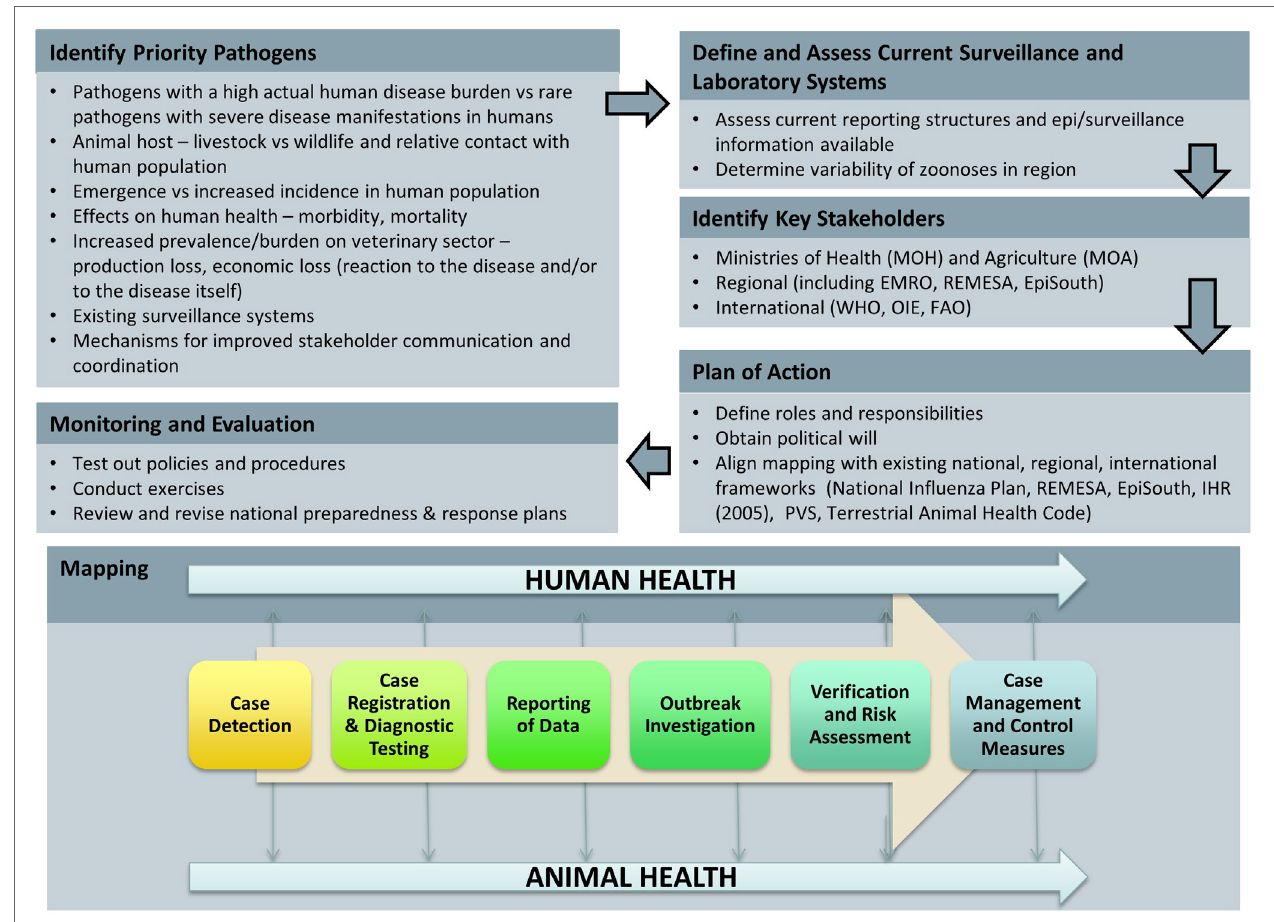
FigUre 2 | identifying priority zoonoses and identification and networks for case management . In order to select three priority zoonotic diseases for analysis, we considered MOH and MOA notifiable disease lists as well as global priority zoonoses. For the three selected priority zoonoses, we developed case studies outlined in a five-step process: (1) case reporting; (2) reporting and sample submission; (3) laboratory testing; (4) case management; and (5) outbreak investigation. The resulting analysis is a systems map that identified the nodes of communication, coordination, and decision-making where the health and veterinary sectors intersect, highlighting both areas of strength and gaps that would benefit from capacity-building